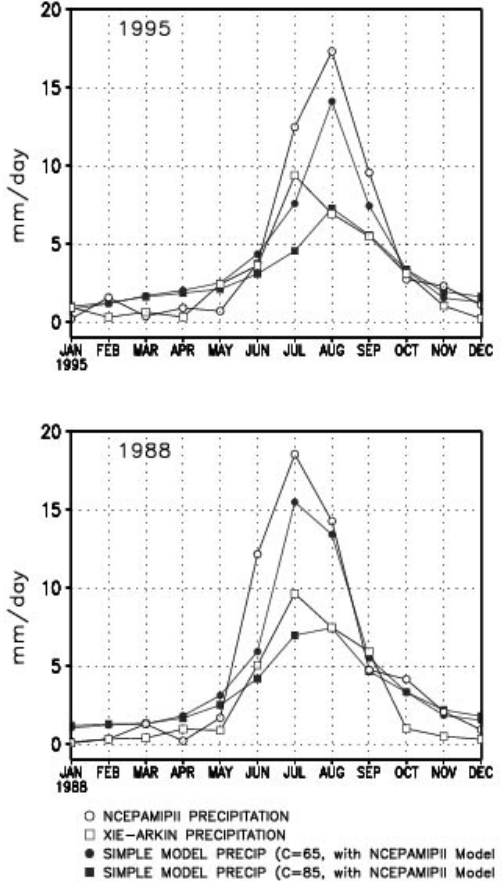
Fig. 5. Seasonal variation of rainfall over India in NCEP GCM in 1988 and